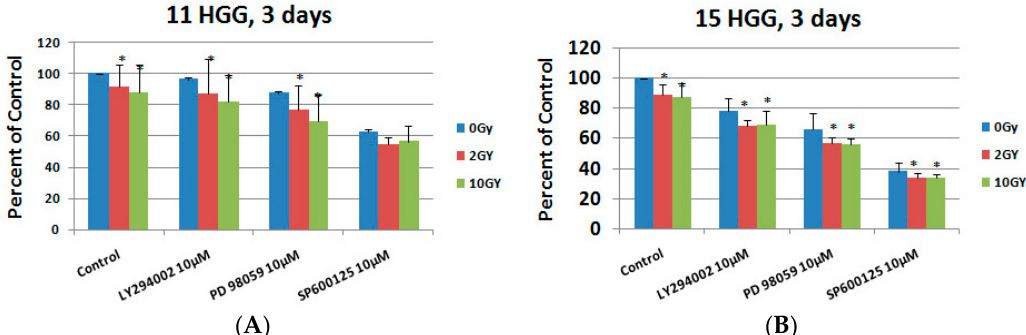
Figure 8. The effect of signal transduction inhibition on ionizing radiation response in 11 ( A ) and 15 HGG ( B ) cells. The cells were seeded in 96-well culture plates (5000 cells/well) then irradiated with 2 (red bar) and 10 Gy (green bar) and treated with 10 µM LY294002, PD 98059, and SP600125 and then cell growth was measured using MTT assays after 3 days. All results show the mean of three independent experiments ± SD, * p < 0.05 vs. irradiated cells.